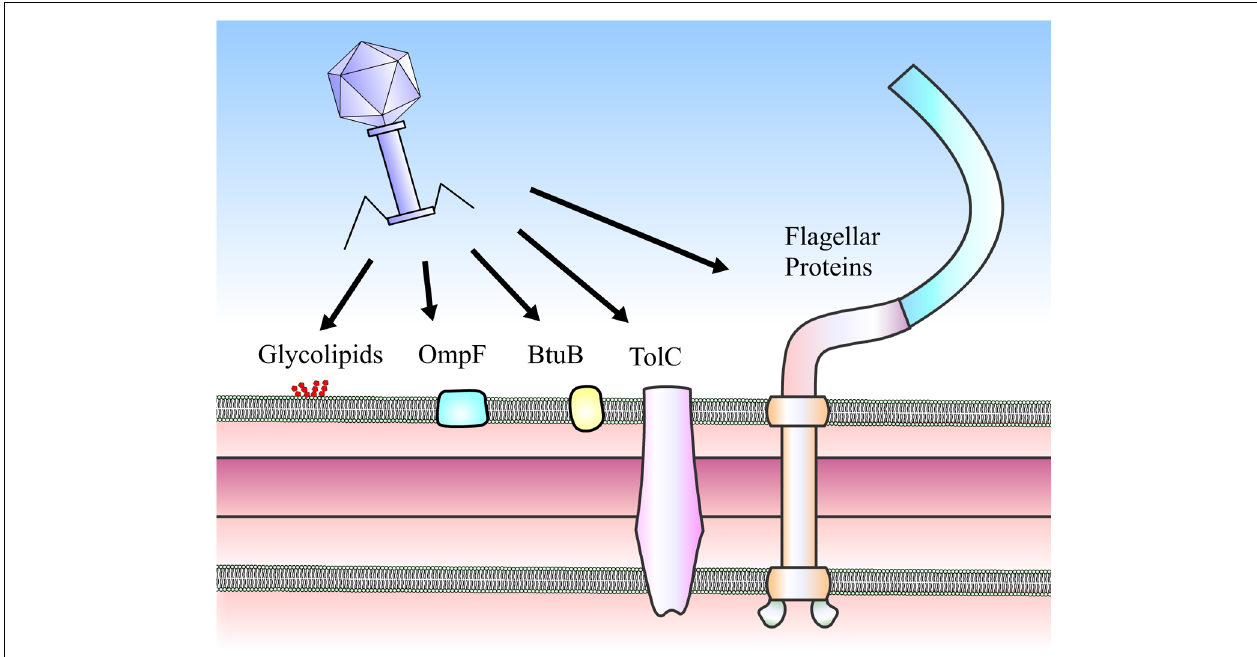
FIGURE 1 | Receptors of Salmonella phages. Phages can use a number of cell surface moieties as receptors, including glycolipids (O- andVi-antigens), integral membrane proteins (e.g., OmpF, BtuB, andTolC) and flagella proteins (FliC, FljB, and